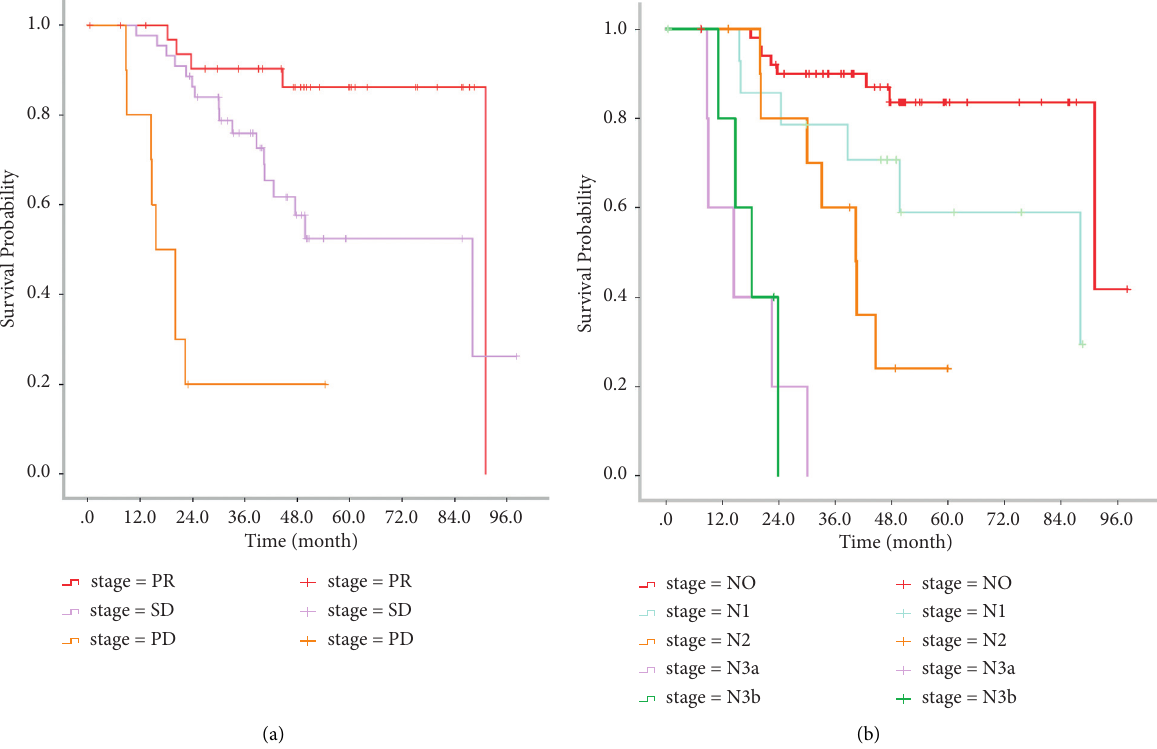
Figure 2: Kaplan–Meier survival analysis for the Mandard score (1-2) group. (a) By the imaging evaluation group. (b) By the ypN group.